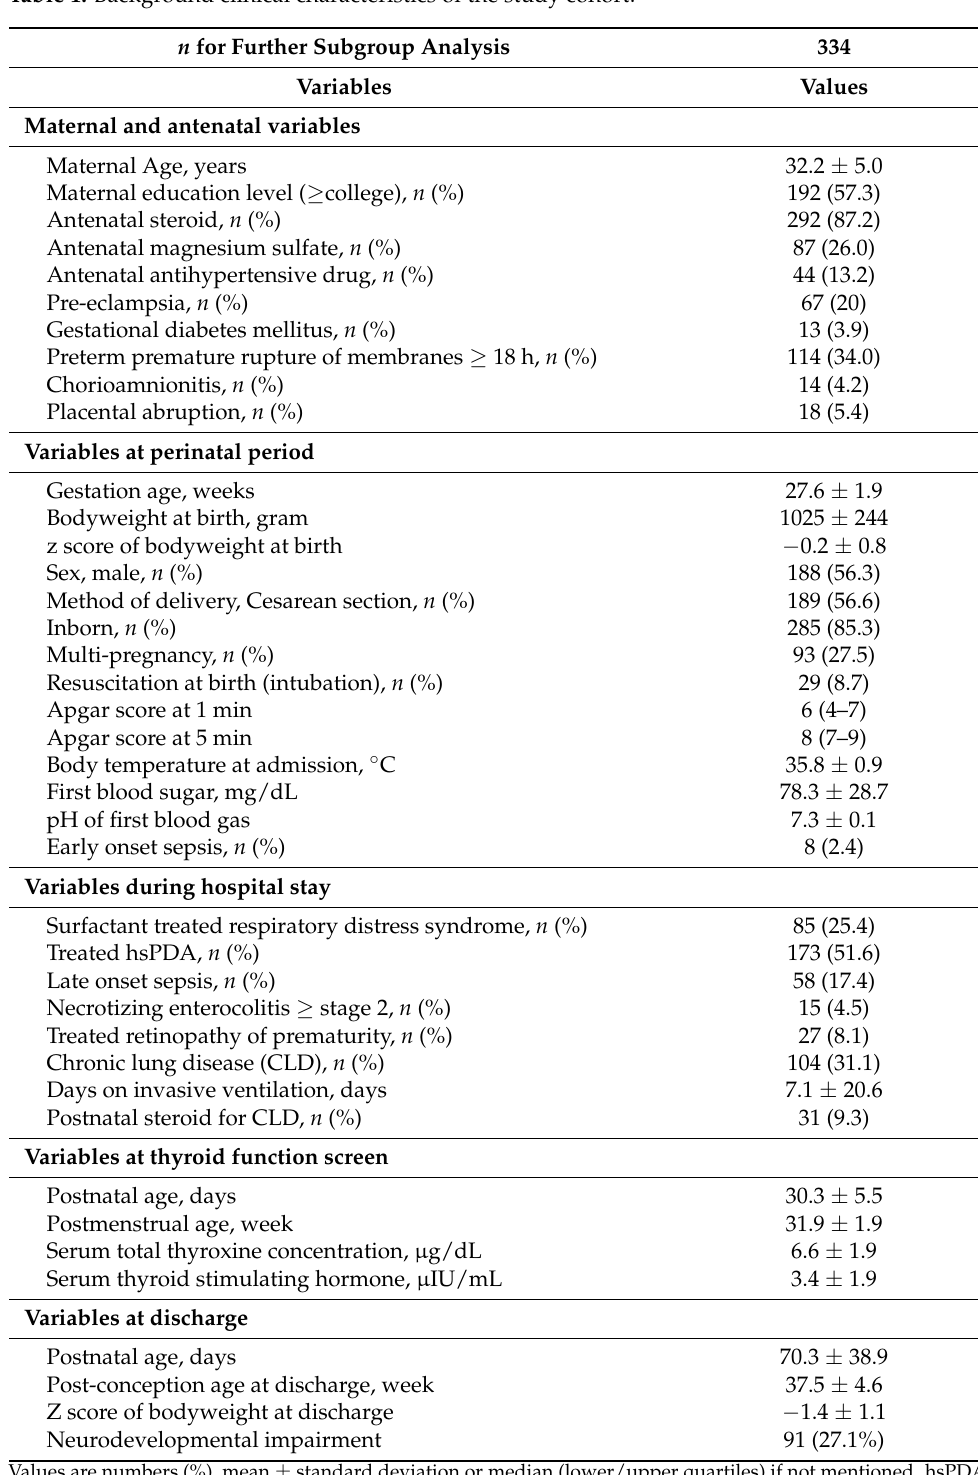
Table 1. Background clinical characteristics of the study